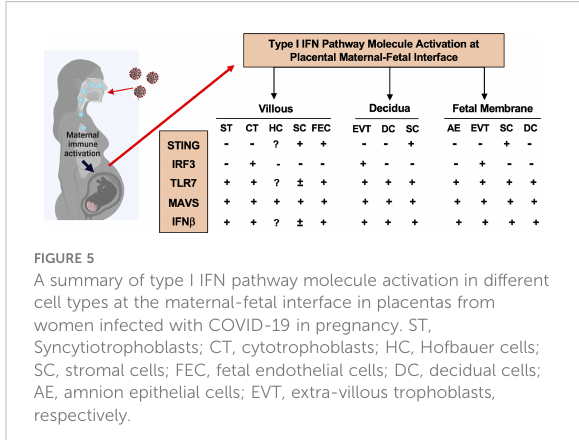
fetal interface correlates with maternal antibody levels or